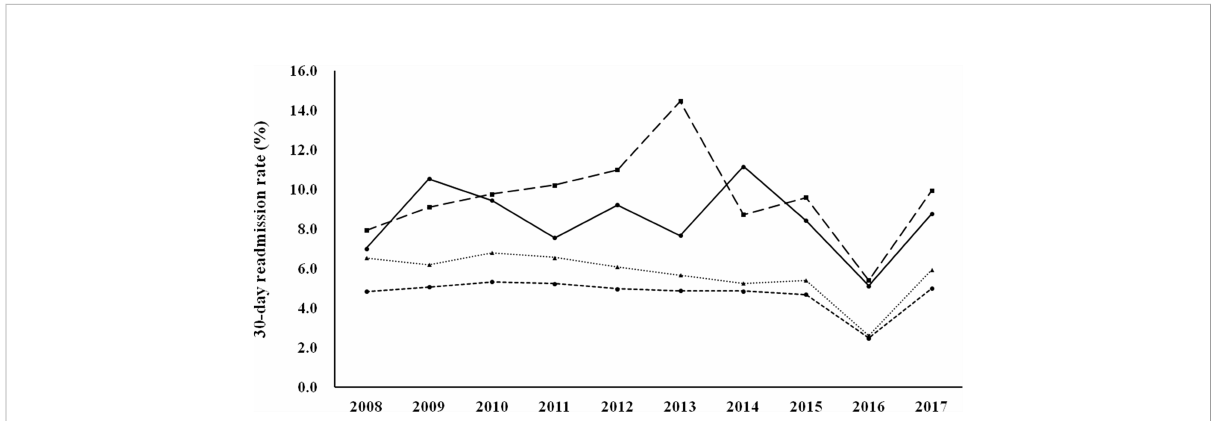
FIGURE 1 30-day readmission rates from 2008 to 2017 according to the diagnostic categories. Circle spots and solid line, known DM. Square spots and dashed line, newly diagnosed DM. Triangle spots and dashed line, GDM. Circle spots and dashed line, no DM/GDM. P for trend 0.046 for